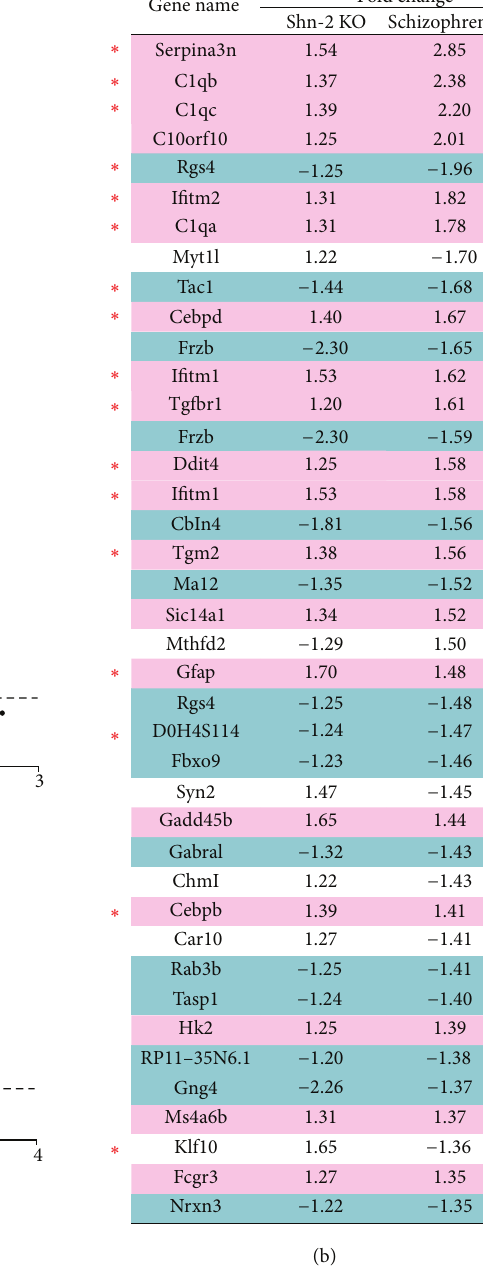
Figure 6: Comparison of gene expression profiles between Shn-2 KO mice and individuals with schizophrenia. (a) Scatter plot of gene expression fold change values in the medial prefrontal cortex (mPFC) of Shn-2 KO mice and Brodmann area (BA) 10 of postmortem schizophrenia brain. (b) Genes differentially expressed in both Shn-2 KO mice and in schizophrenia. Red indicates gene upregulation and blue indicates downregulation in both Shn-2 KO mice and in schizophrenia. The top 40 genes with respect to the fold change values